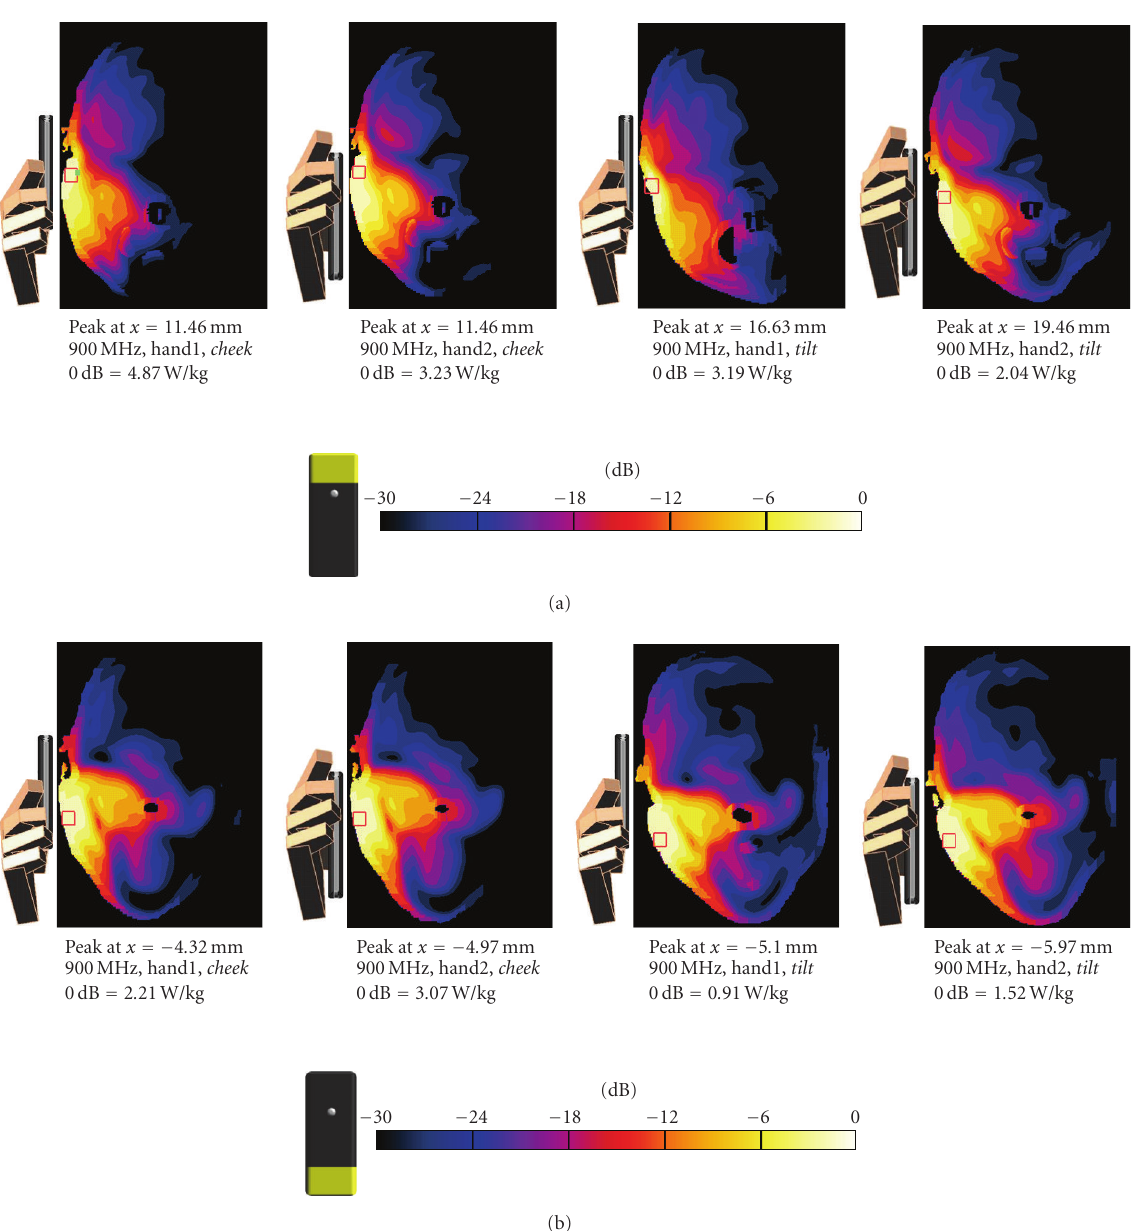
Figure 9: Sliced distribution of the averaged-peak SAR 1g in the yz -plane, normalized to 0.6 W input power, of the HR-EFH at di ff erent positions due to the exposure at 900MHz of (a) handset model-B1 and (b) handset model-B2.